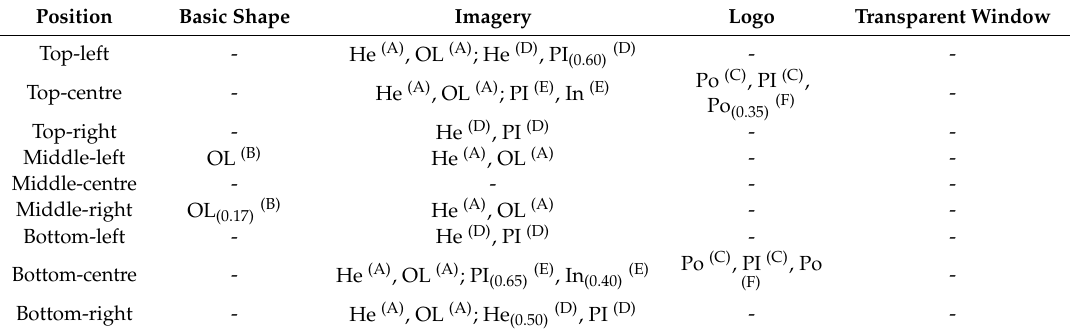
Table 1. A review of the effects of position on packaging design for different design elements on commonly-reported behavioural and evaluative